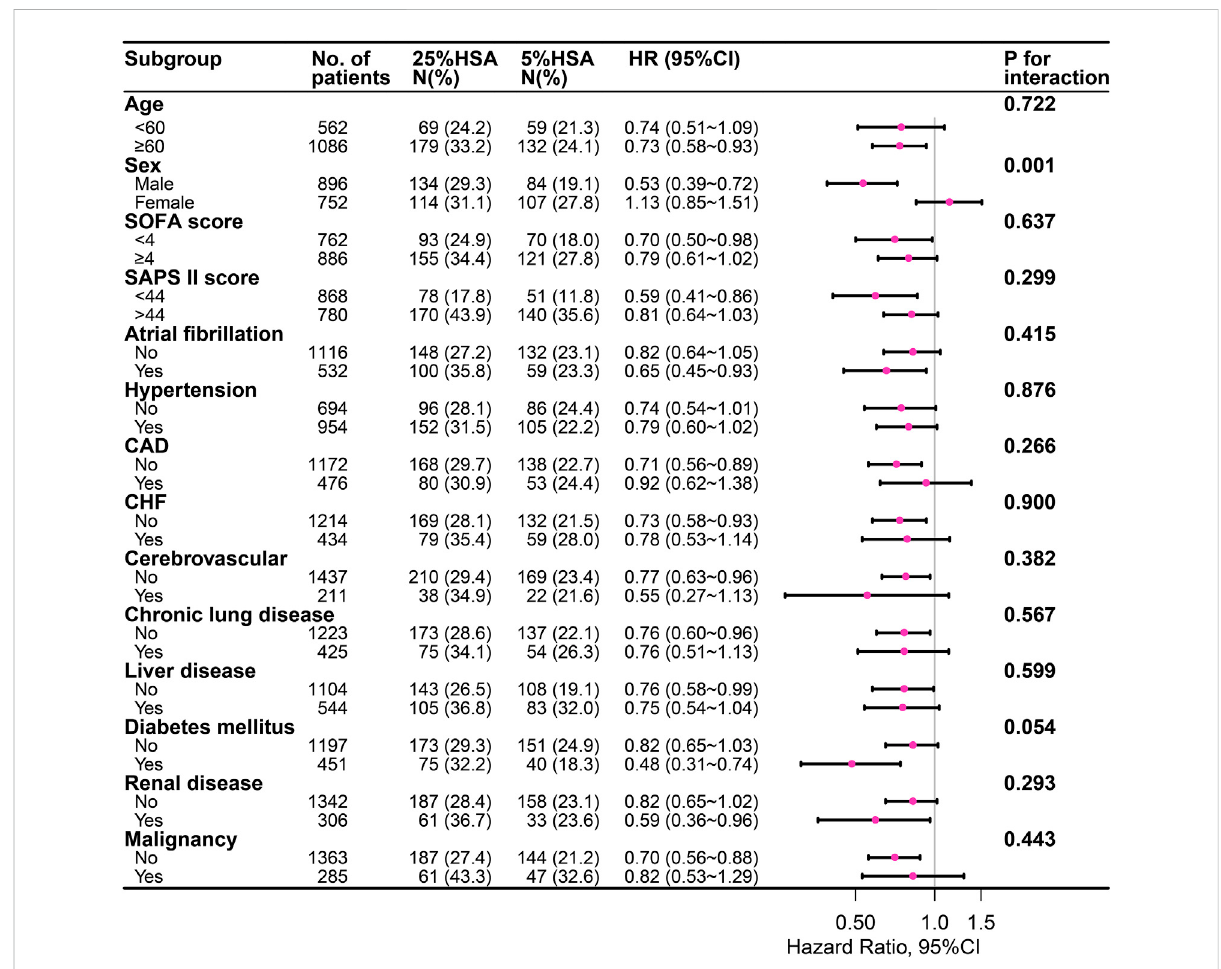
FIGURE 3 The association between different concentrations of HSA and 28-day mortality in subgroups. HSA, human serum albumin; SOFA, Sequential organ failure assessment; SAPS II, Simpli fi ed acute physiology score II; CAD, coronary artery disease; CHF, congestive heart failure.